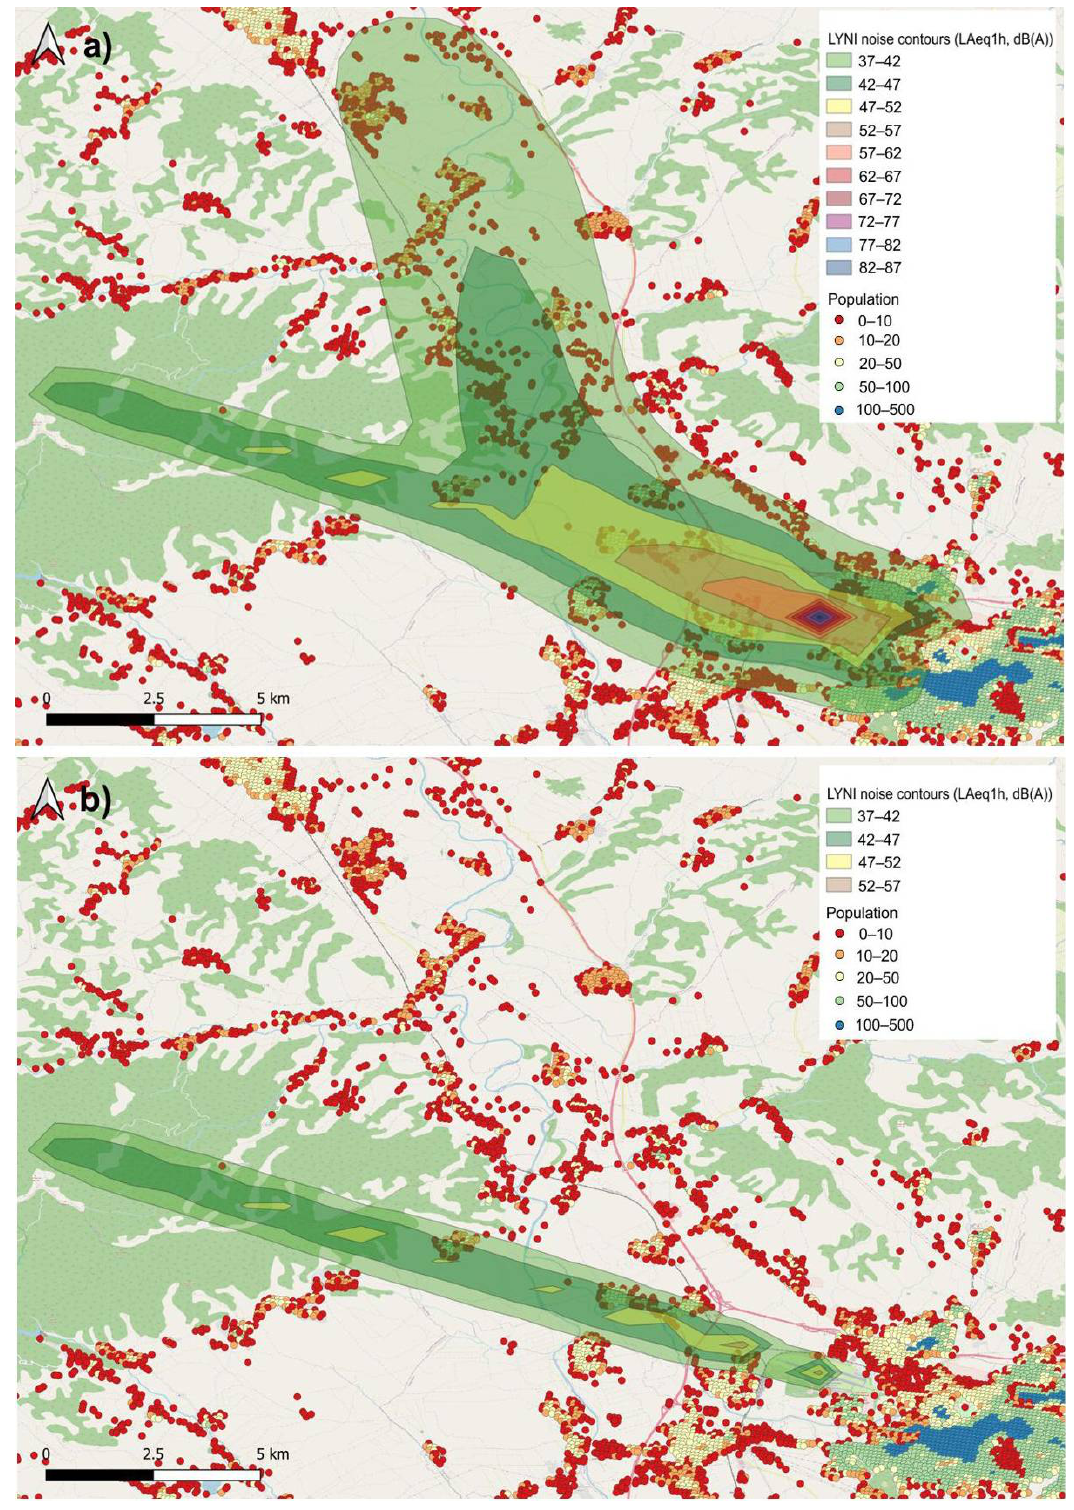
Figure 6. L Aeq ,1h noise contours for Niš Airport, ( a ) with TAM-related delays and ( b ) without TAM- related delays.